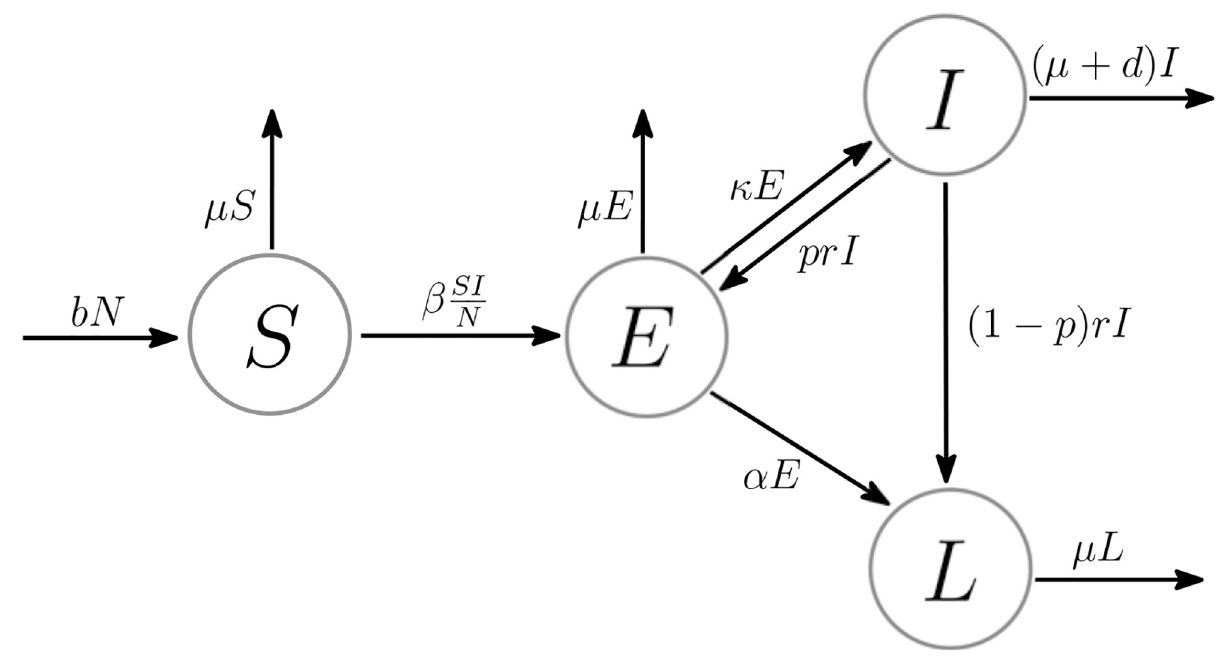
Fig 1. Flow diagram of TB dynamic